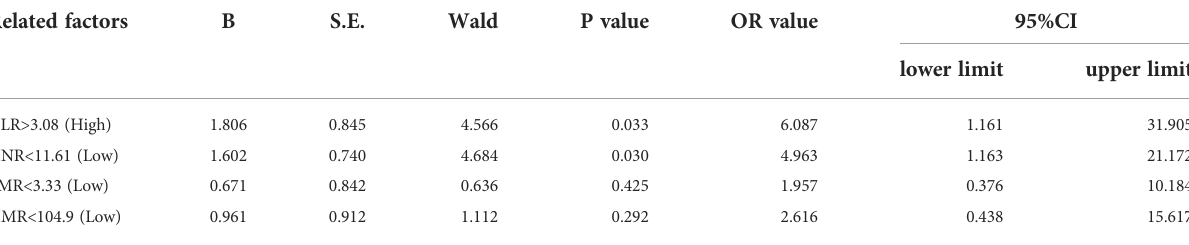
TABLE 6 Multivariate Logistic regression analysis of N L R, LMR, HNR, and HMR (classi fi ed in the two-group categories) in the prediction of NSCLC metastasi. Related factors